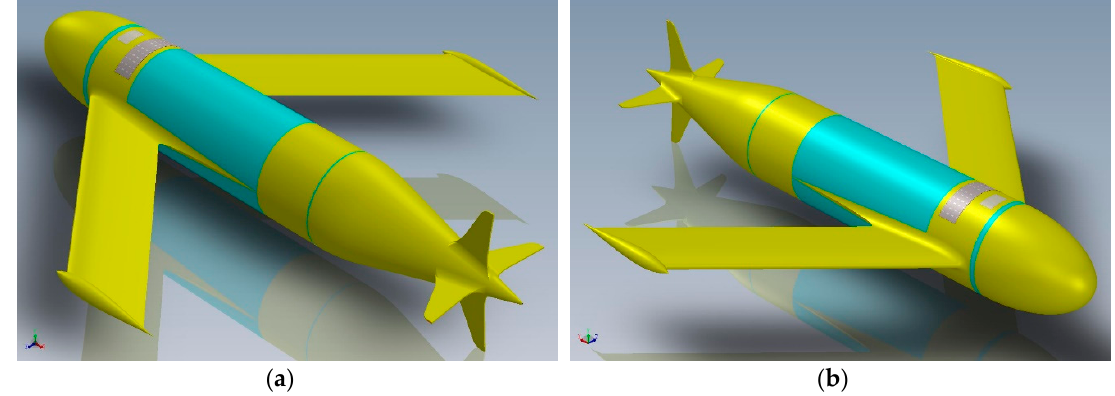
Figure 1. Perspective view of the Underwater Glider Mk. III. ( a ) Rear/port; ( b ) front/starboard.